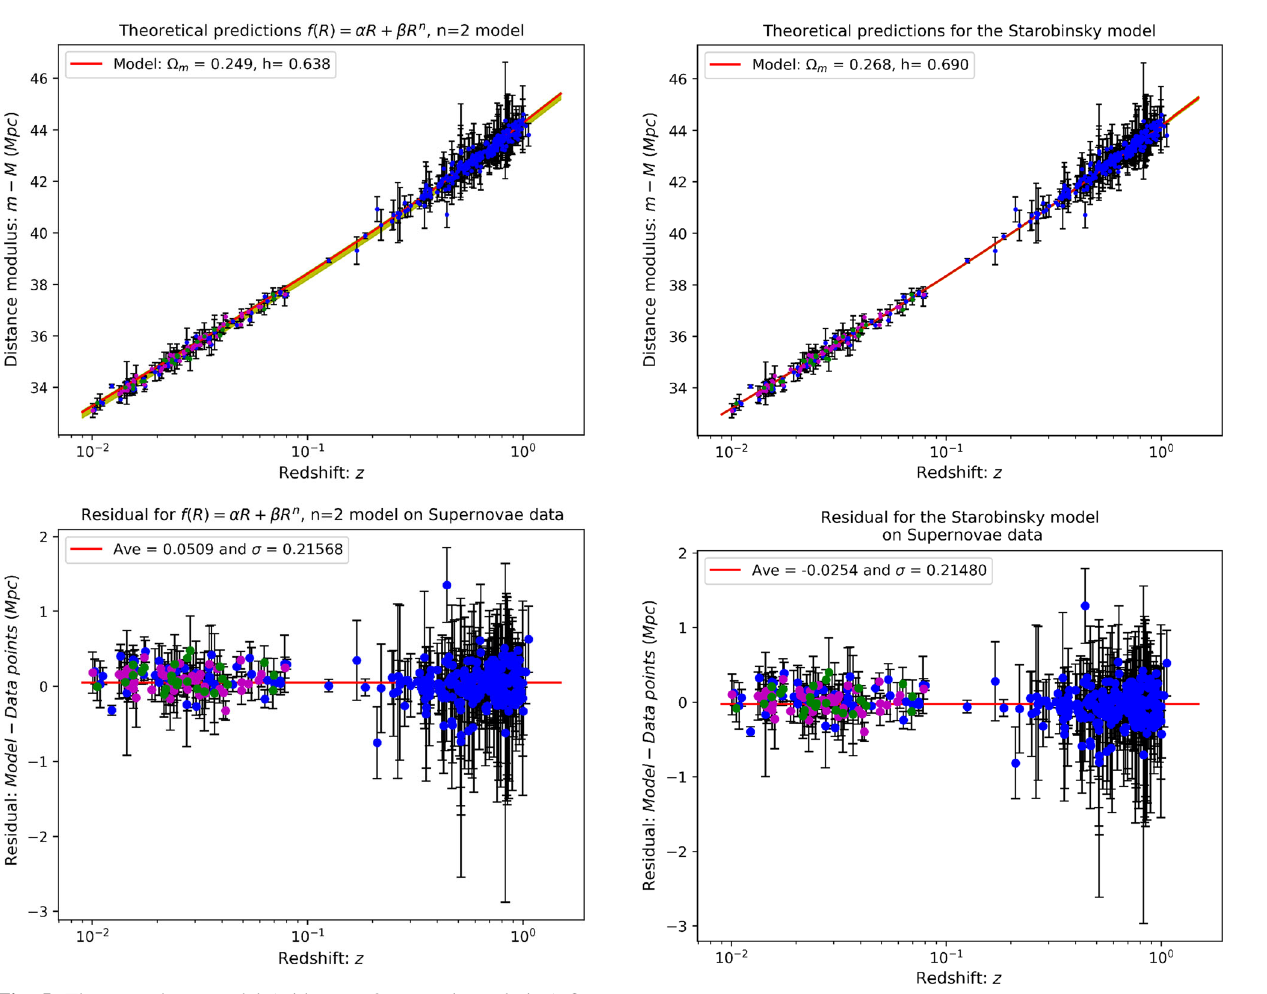
Fig. 5 The second toy model (with n = 2 - negative solution) fit- Fig. 6 The Starobinsky model fitted to the Supernovae Type 1A data. ted to the Supernovae Type 1A data. With cosmological parameter With cosmological parameter values calculated by the MCMC simu- values calculated by the MCMC simulation as Ω m = 0 . 249 + 0 . 102 − 0 . 101 lation as Ω m = 0 . 268 + 0 . 027 − (constrained), H 0 = 69 . 0 + 0 . 5 − km (unconstrained), H 0 = 63 . 8 + 4 . 6 − (unreliably constrained), q 0 = 0 . 024 2 . 7 s . Mpc strained), q 0 = − 0 . 512 + 0 . 328 − (unconstrained), and q 1 = 0 . 037 + 0 . 991 − = − 0 . 633 + 0 . 081 − 0 . 575 + 0 . 040 0 . 265 − 0 . 046 (constrained), and q 1 − 0 . 049 (unreliably con- (unconstrained), while the arbitrary free parameters were calculated strained), while the arbitrary free parameters were calculated to be to be β = 5 . 284 + 3 . 191 − (unconstrained) and n = 4 . 567 + 3 . 346 − α = 19 . 642 + 2 . 967 β = 0 . 903 + 0 . 070 2 . 981 − 0 . 107 (unre- − 1 . 753 (unreliably constrained) and